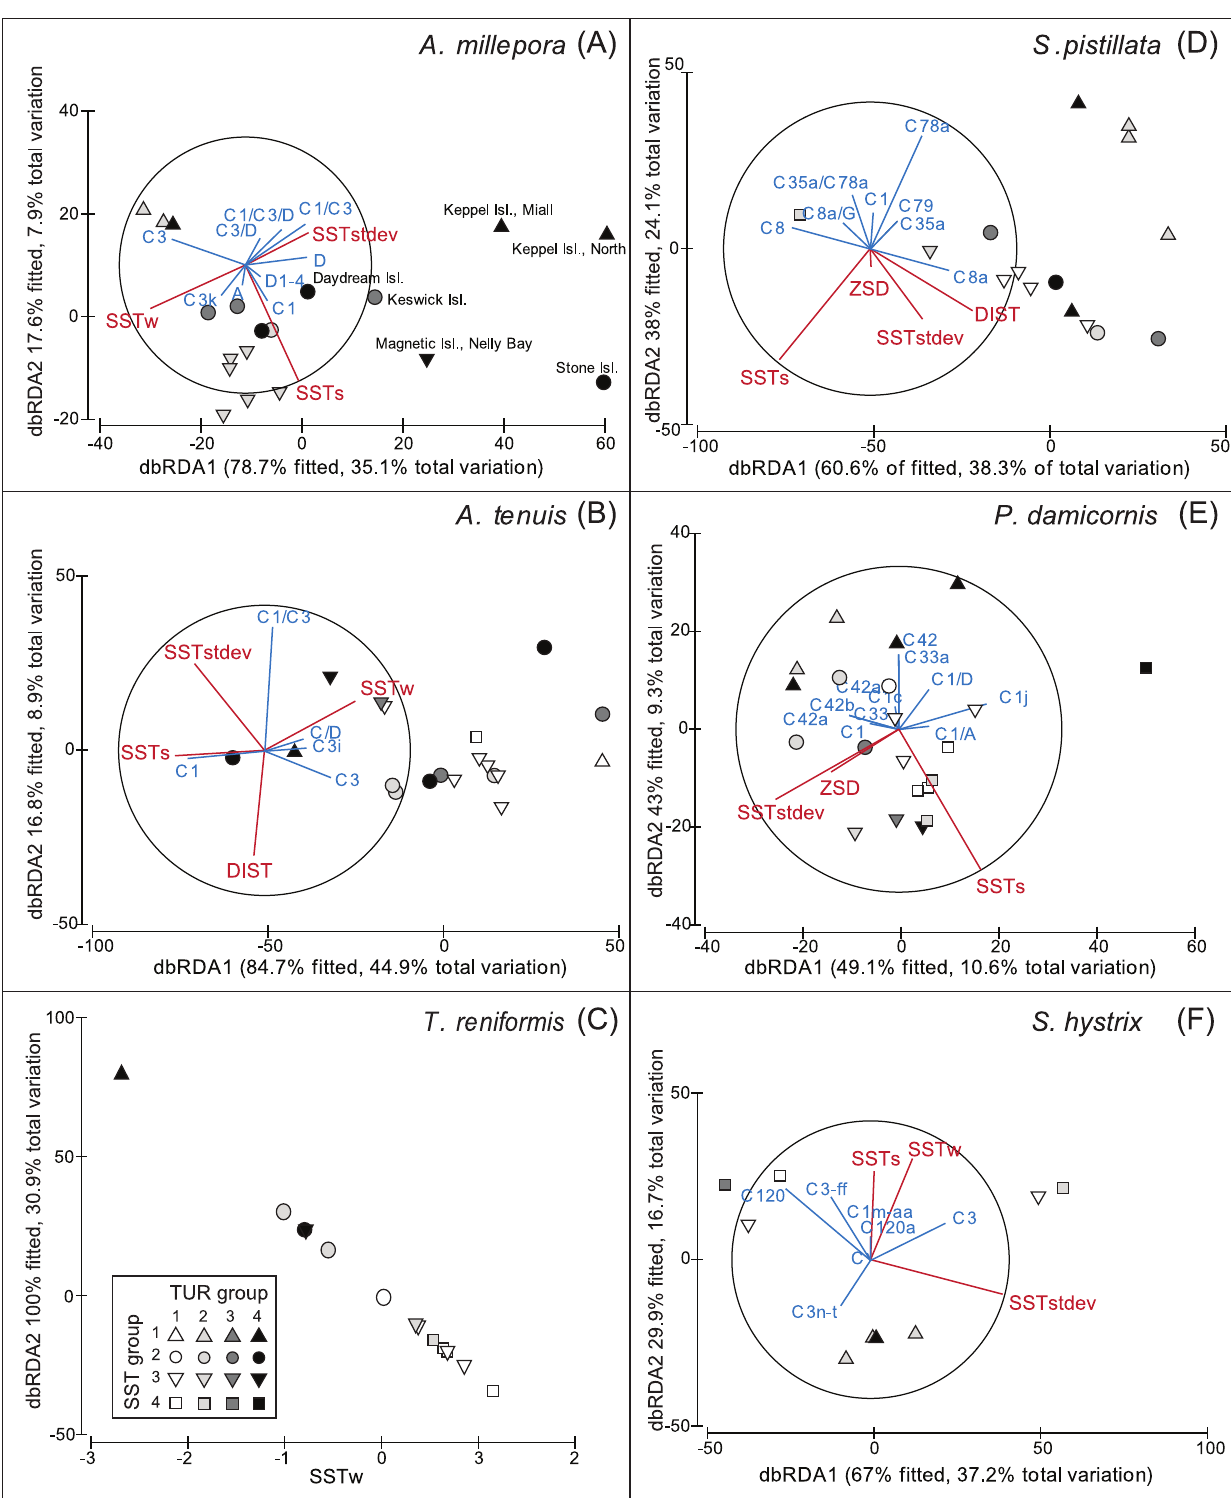
Figure 4. DbRDA ordination relating environmental variables to Symbiodinium ITS-types per host species. Presence/absence data of Symbiodinium ITS-types in (A) Acropora millepora , (B) Acropora tenuis , (C) Turbinaria reniformis, (D) Stylophora pistillata , (E) Pocillopora damicornis and (F) Seriatopora hystrix at different sites are shown in biplot projections (log transformed and normalized environmental data is shown in red and symbiont ITS-types in blue). For illustrative purposes only, sites are designated a sea surface temperature (SST) group (indicated by symbols) and turbidity (TUR) group (indicated with different shades of grey). The ‘% of fitted’ indicates the variability in the original data explained by the fitted model and ‘% of total variation’ indicates the variation in the fitted matrix.